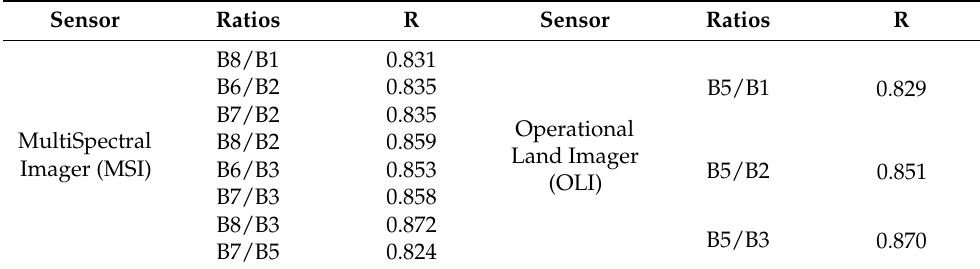
Table 1. Band combinations with correlation coefficient (R) greater than